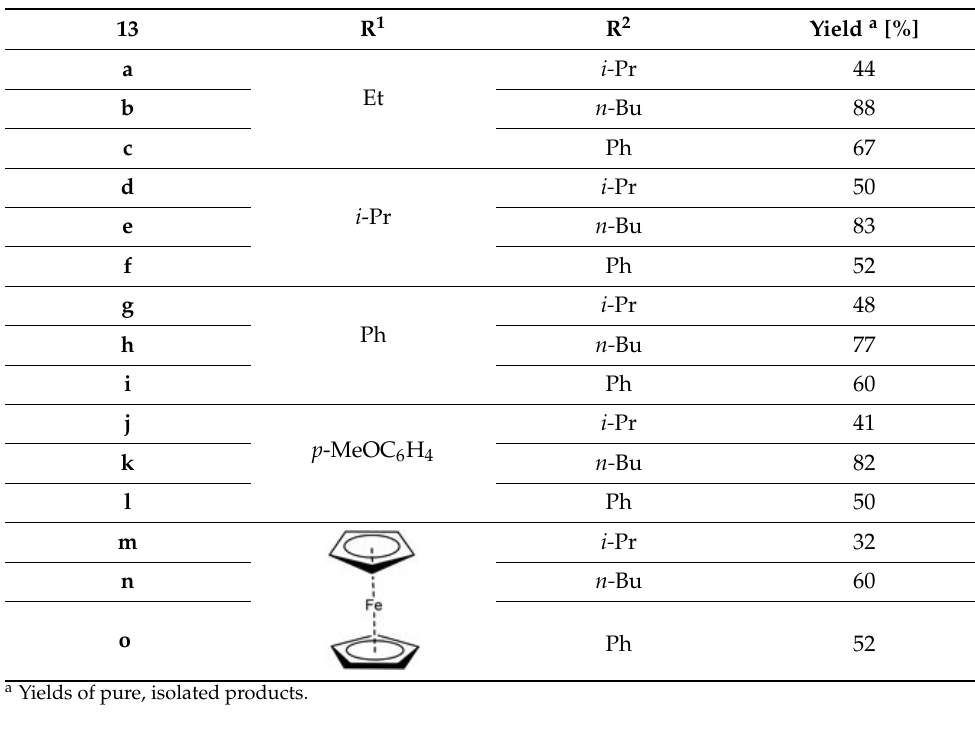
Table 4. Yields of trans -2,6-disubstituted 3-methylidenetetrahydropyran-4-ones trans - 13a–o obtained.